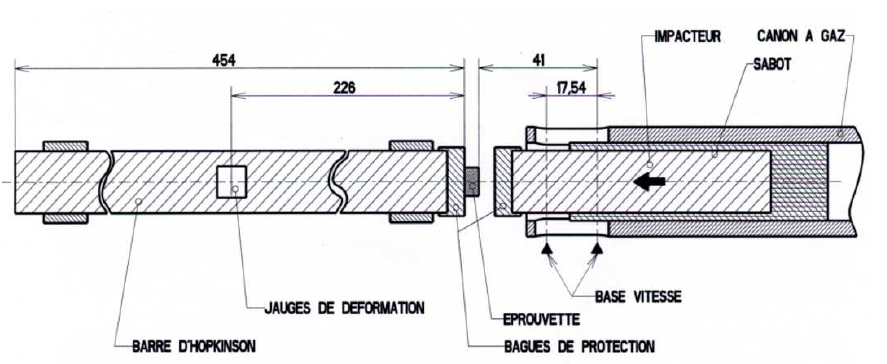
Fig. 5. Direct Impact Hopkinson Pressure Bar technique (DIHPB).